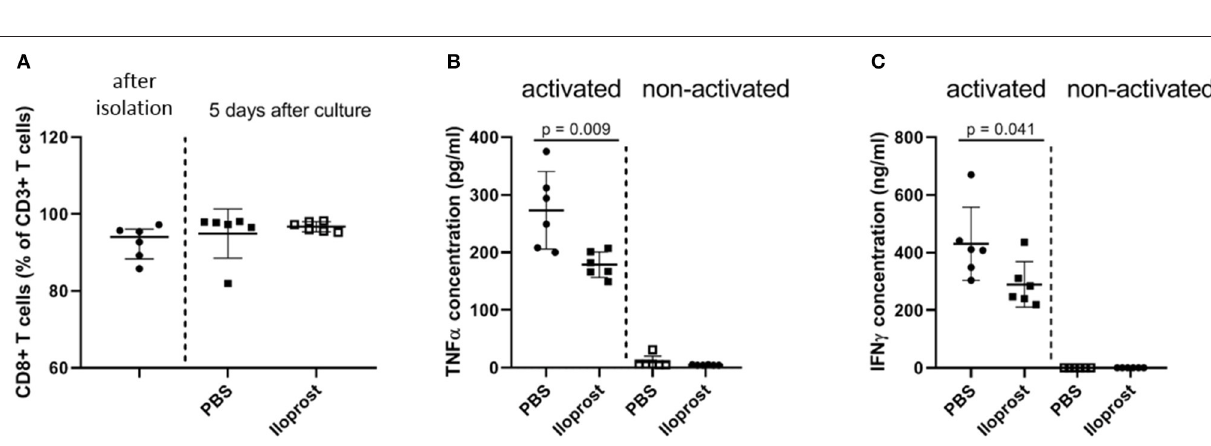
FIGURE 3 | Immunomodulatory effects of Iloprost on isolated CD8 + T cells. The purity of the isolated CD8 + T cells after bead-based separation as well as after in vitro stimulation was confirmed by flow cytometry (A) . CD8 + T cells were stimulated by α -CD3/ α -CD28 in addition to either PBS or 3 µ M Iloprost. The following secreted cytokine concentrations were evaluated: TNF α (B) and IFN γ (C) ; n =